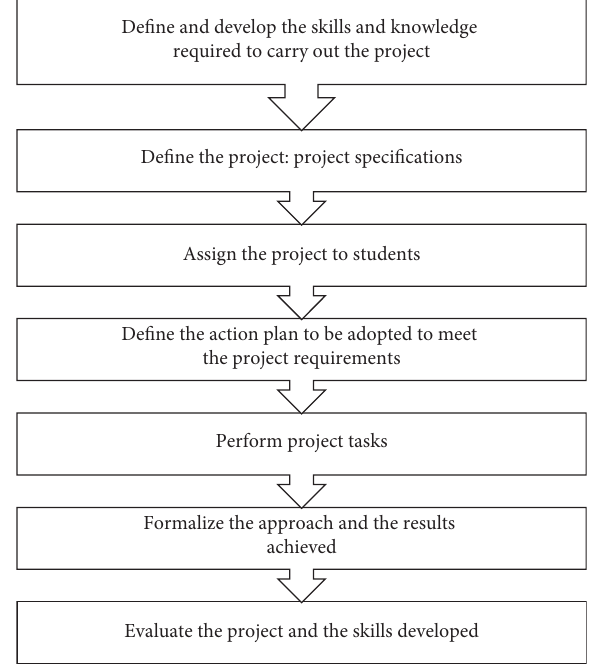
Figure 1: Implementation phases of project-based learning.